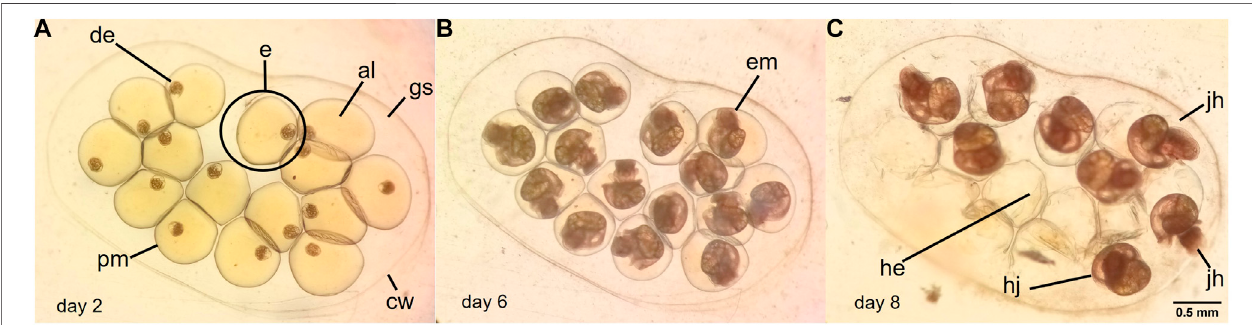
FIGURE2| Eggmasswith15eggsfrom Biomphalariastraminea adultsnailtreatedwithTW.TheeggmasswasinTWtoo. (A) day2ofdevelopment, (B) day6, (C) day 8. e: egg, de: developing embryo, al: albumen or perivitelline fl uid, pm: perivitelline membrane, cw: capsular wall; gs: gelatinous substance, he: hatched egg, jh: juvenile hatching, hj: hatched